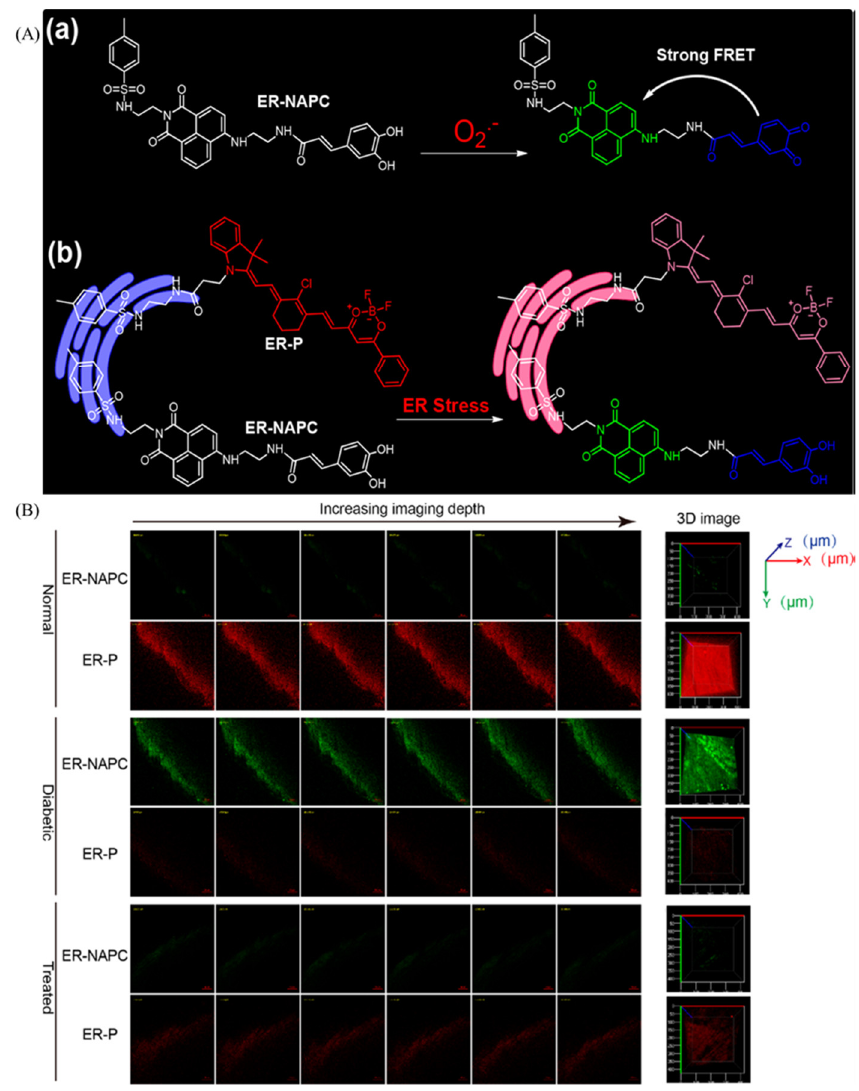
Figure 22. ( A ) Structure of ER-NAPC and O 2•− ( a ) and polarity ( b ) sensing mechanism. ( B ) Confocal pictures of endogenous polarity and O 2•− in myocardial tissues stained with ER-NAPC and ER-P. Reproduced from [107] with permission of the American Chemical Society, copyright 2018.